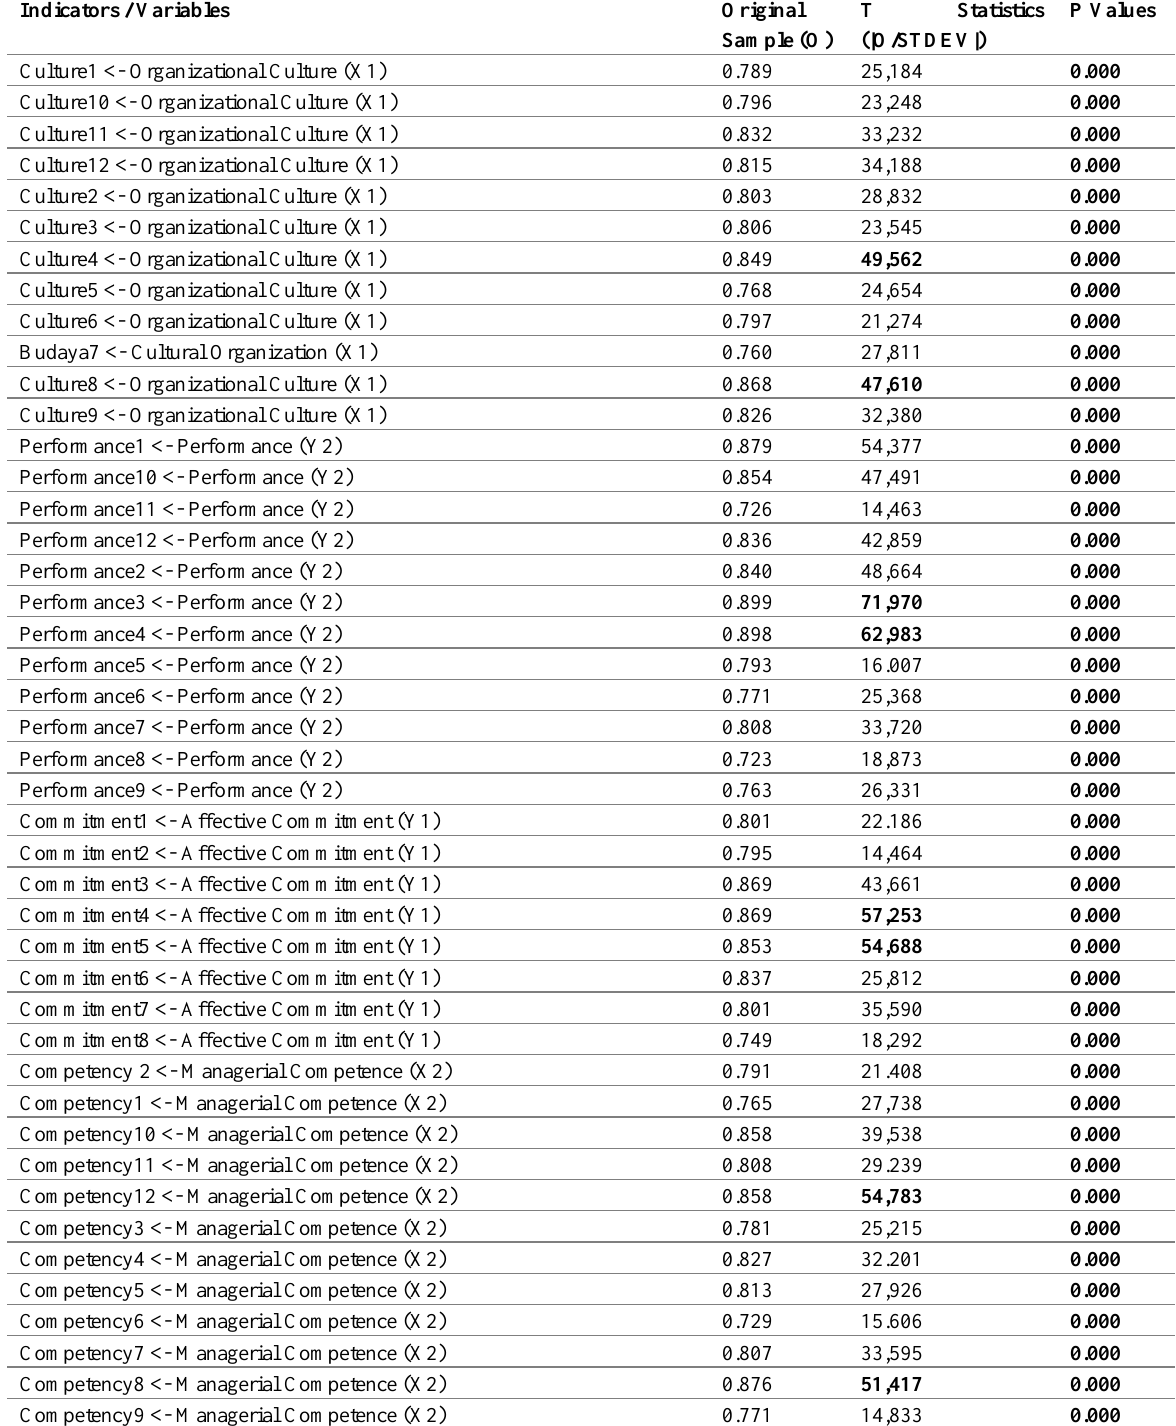
Table 21: Estimation of Path Coefficients and T-statistics Outer